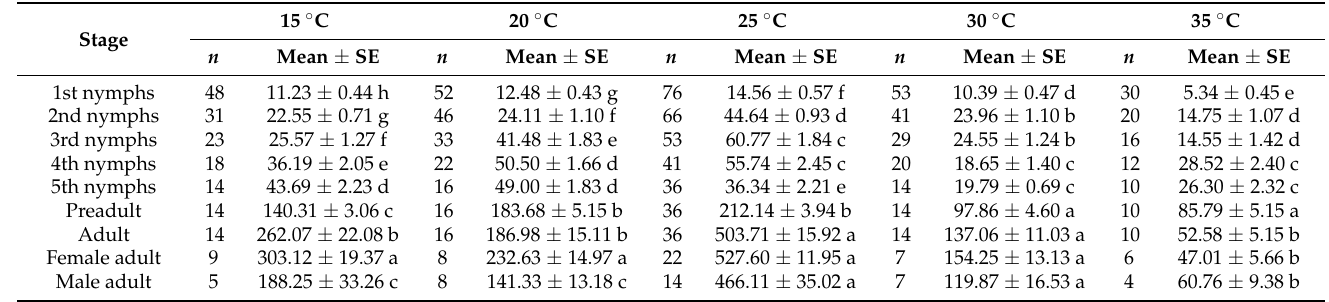
Table 3. Total predation rate (Mean ± SE) at each stage j excluding individuals that died in stage j ( P j ).